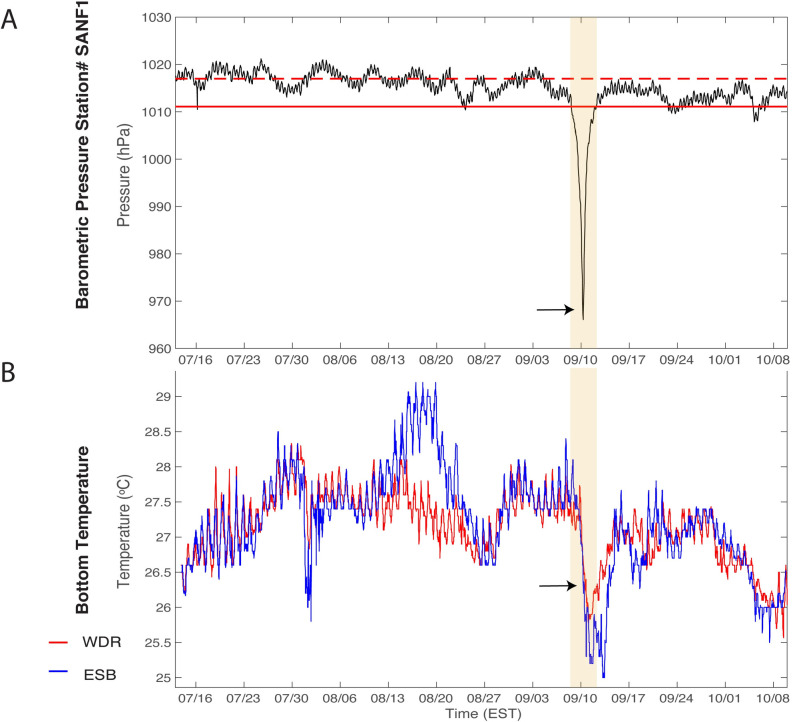
Environmental data.(A) Barometric pressure data from Sand Key Lighthouse, FL (Station ID SANF1 24.456°N, 81.877°W) NOAA-National Data Buoy Center is shown as a black line with the median (dashed red) and the lower 2.5% confidence interval (solid red). (B) Mean hourly bottom temperature (°C) from hydrophone sensor for Western Dry Rocks (red) and Eastern Sambo (blue). The orange bar represents Hurricane Irma duration and the black arrow indicates the times of landfall at Cudjoe Key FL on September 10, 2017 08:00 EST.